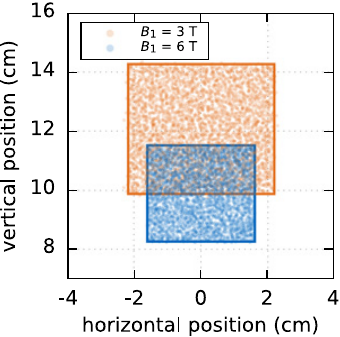
Figure 6. Simulated e − / p + -beam cross-section at the center plane of the selector coil, with B 1 = 3T and 6T. Dots represent simulated electrons tracks, while the frames correspond to field lines from the edges of the neutron beam. The vertical zero position corresponds to the axis of the long solenoid.